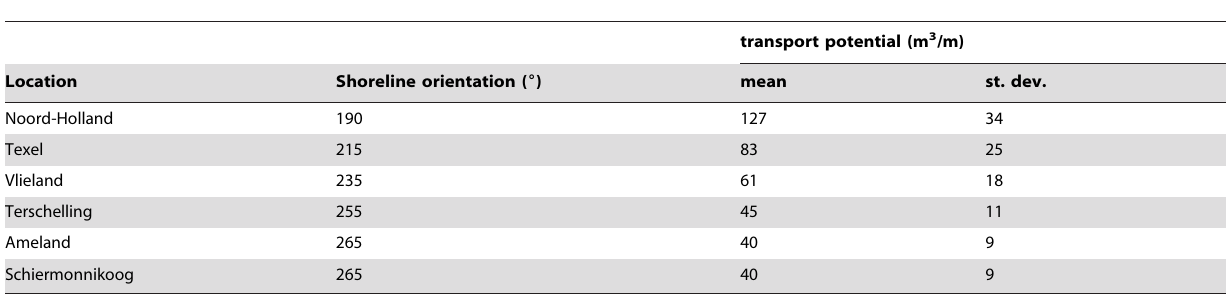
Table 2. Average and standard deviation of yearly transport potential, calculated from 1980–2012 data.